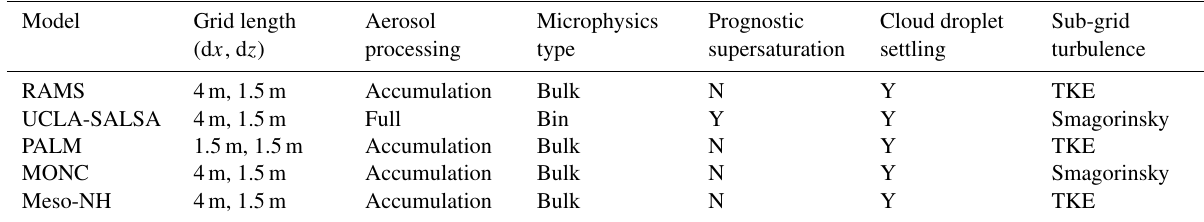
Table 2. LES model details: horizontal (d x ) and vertical (d z ) grid length, type of aerosol processing, microphysics parameterisation details, and type of sub-grid turbulence scheme (TKE = turbulent kinetic energy